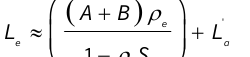
Table 1. Bands and wavelength range of SPOT-5 satellite Before the atmospheric correction, first make the